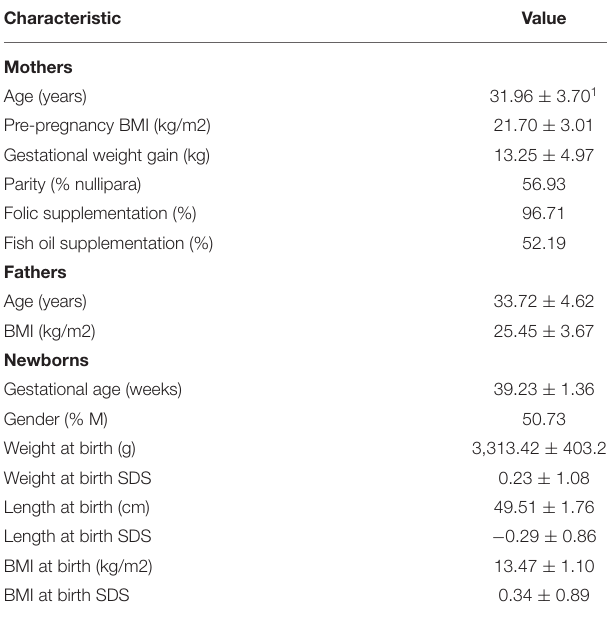
TABLE 1 | Characteristics of parents and newborns ( n =